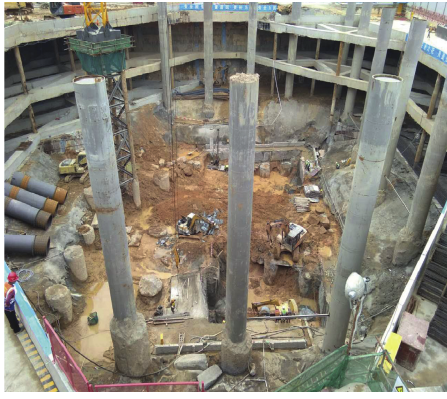
Figure 1: Overview of the